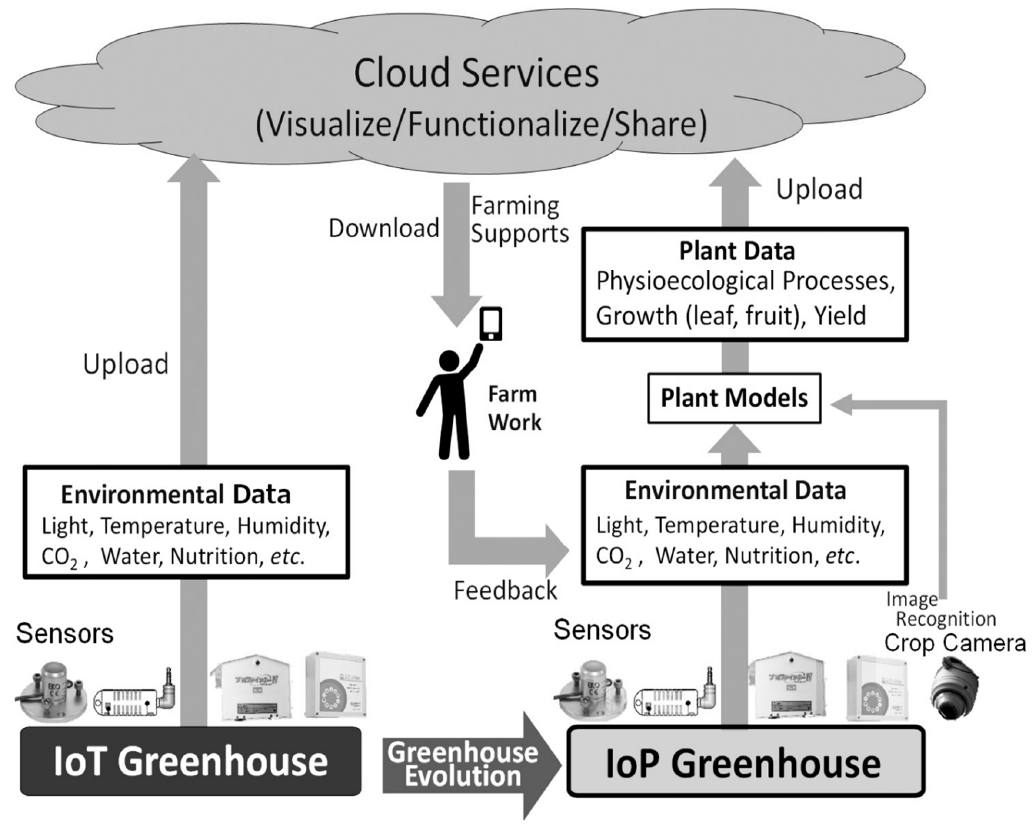
Figure 3. Core attributes and the link between IoP and IoT [56].